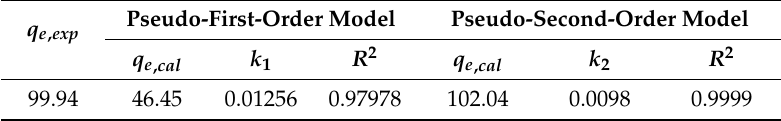
Table 1. Kinetic parameters for Pb(II) adsorption on MIL-125-CS at different contact times. q e, exp